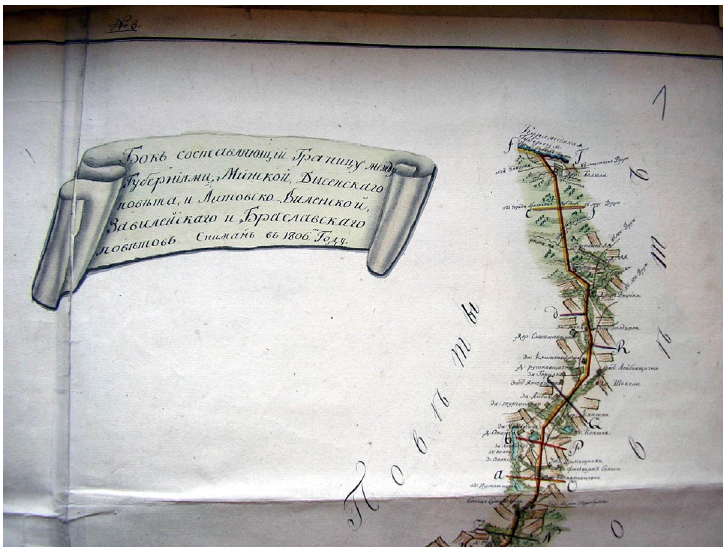
kurioje dar prisimenama valak ų reforma ir Lietuvos Statutas. Žem ė lapi ų depas 1812 m. reorganizuotas į Karo topografijos dep ą prie Generalinio kariuomen ė s